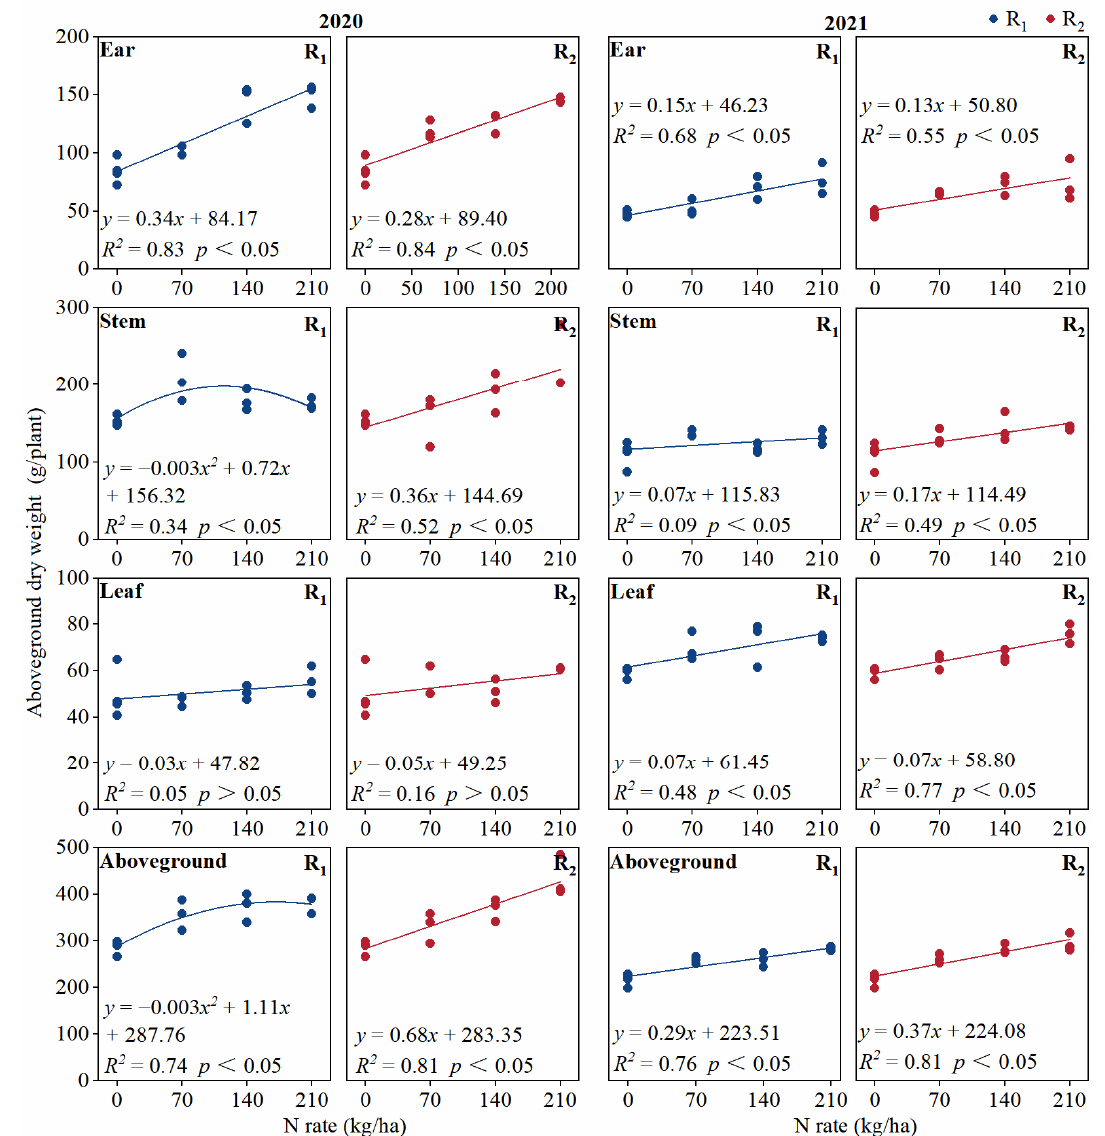
Figure 5. Dry weights of forage maize plants at harvest under different treatments in 2020 and 2021.